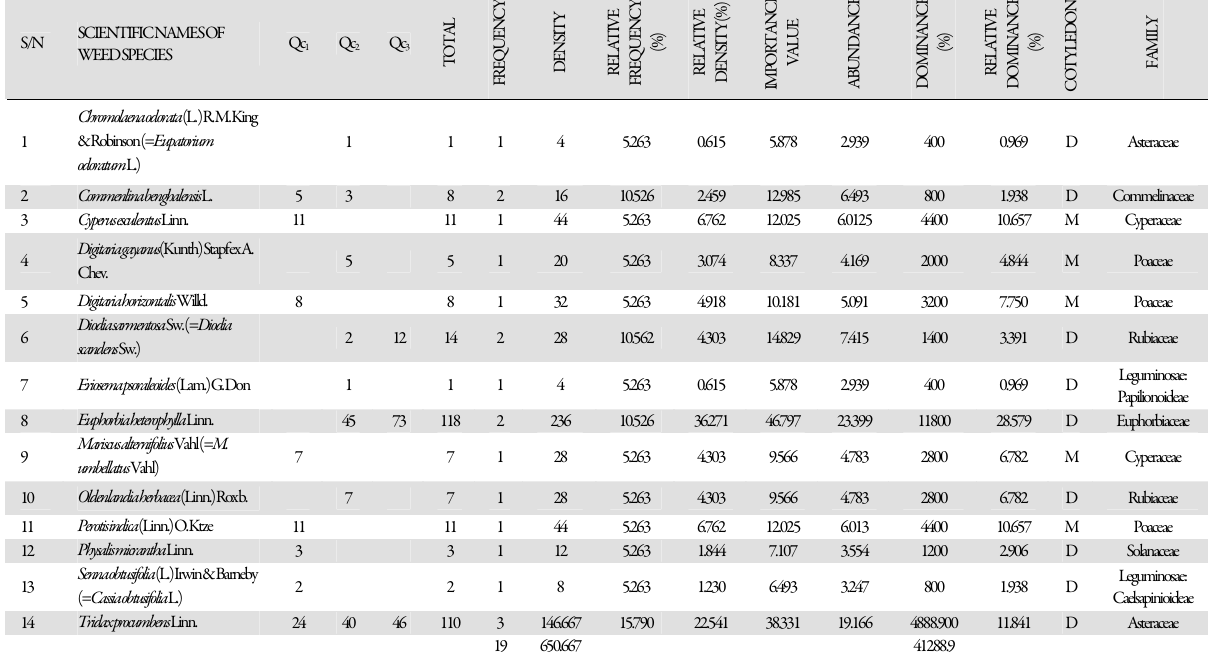
Tab. 8. Weed flora and species parameter for control plot at 6WAP